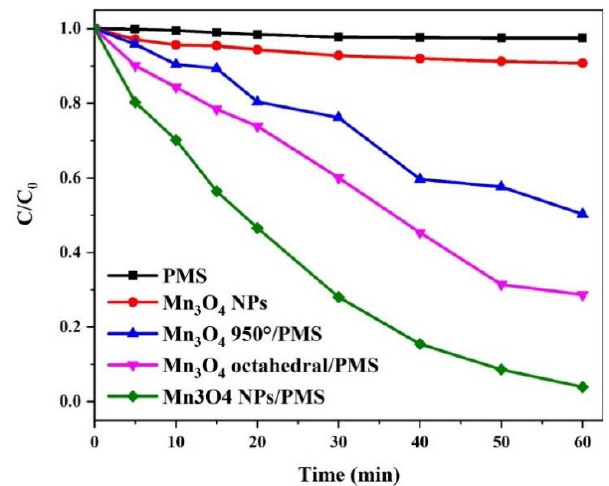
Figure 5. Phenolic degradation efficiency in catalytic oxidation using manganese oxide catalysts. Reaction condition: phenol concentration = 25 ppm, catalyst = 0.4 g/L, PMS = 2 g/L, and t = 25 °C.